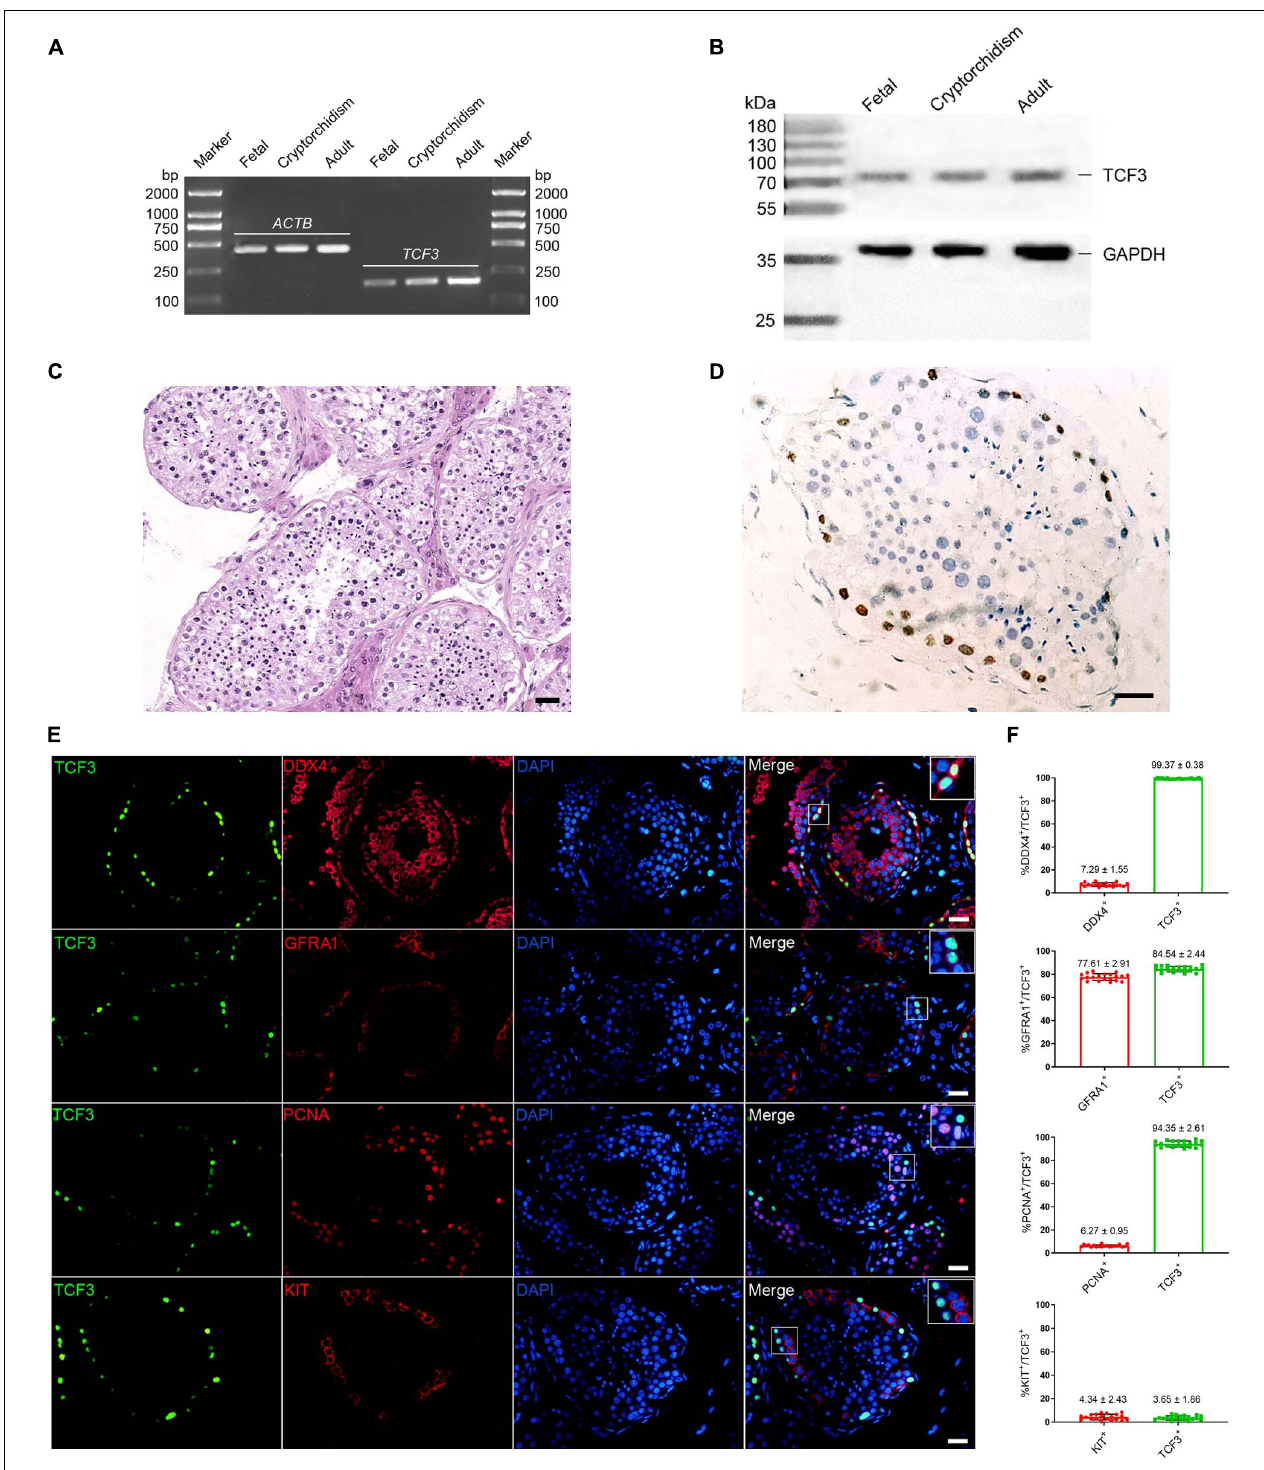
FIGURE 1 | The expression of TCF3 in human testes. (A) RT-PCR showed TCF3 mRNA in human fetal, cryptorchidism, and adult testes. ACTB served as the loading control of total RNA. (B) Western blotting illustrated the expression of TCF3 protein in human fetal, cryptorchidism, and adult testes. GAPDH was used as the loading control of total protein. (C,D) Immunohistochemistry revealed cellular localization of TCF3 in human testis with normal spermatogenesis. (E) Double immunostaining showing the co-expression of TCF3 with DDX4, GFRA1, KIT, and PCNA in human testis with normal spermatogenesis. At least 20 seminiferous tubules were counted. (F) Percentages of TCF3 + cells with DDX4, GFRA1, PCNA, and KIT expression. Scale bars: (C–E) , 50 µ m.